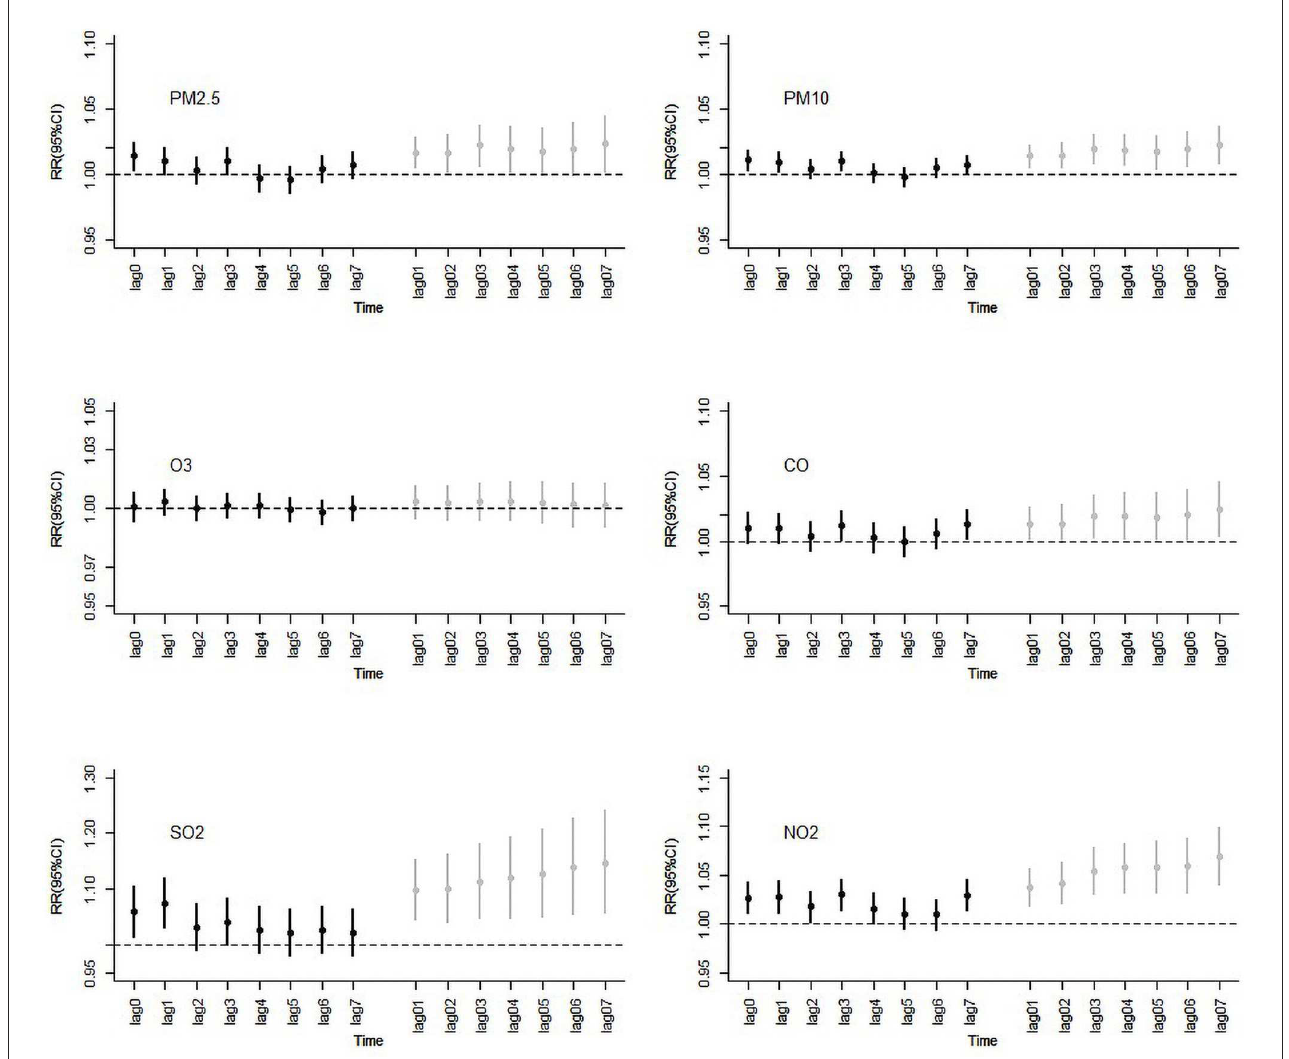
FIGURE1 RR (Rate ratios) and 95% CIs (confidence intervals) following a 10-units increase on lag0, lags1–7, and lags01–07 ambient air pollution concentrations and hospital admissions for pneumonia and asthma, Ningbo,